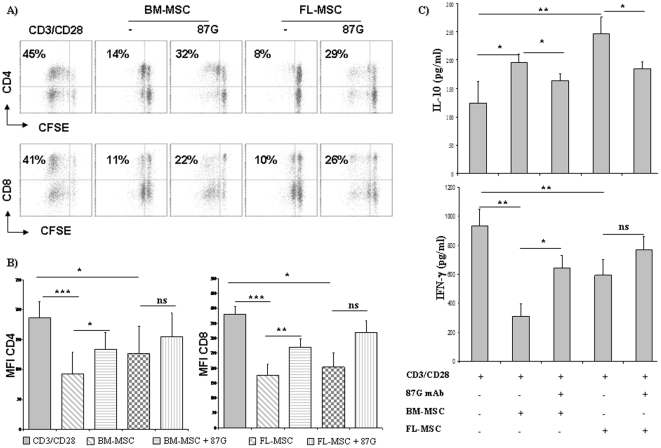
MSC facilitate a CD4low and CD8low subset expansion that secrete IL-10.(a) Surface CD4 and CD8 expression in CFSE-stained activated lymphocytes was evaluated by flow cytometry in the absence or presence of 20% adult and fetal MSC for 4 days. 87G anti-HLA-G antibody was added to evaluate the involvement of HLA-G. One representative experiment is shown. (b) CD4 and CD8 expression of T cells incubated with MSC (expressed as MFI, Mean Fluorescence Intensity) are presented. Error bars represent SD. P-values were calculated using Student's t-test. *P<0.05, **P<0.01; ***P<0.001, ns = not statistically significant. (c) CD3/CD28-activated T cells were cultured in the presence of BM-MSC and FL-MSC (passage 2–4 and 12–15 for adult and fetal cells, respectively) for 4 days and IL-4, IL-5, IFN-γ and IL-10 production was evaluated by using ELISA assay. Averages of four independent experiments are shown. P-values were calculated using Student's t-test. *P<0.05, **P<0.01; ***P<0.001, ns = not statistically significant.